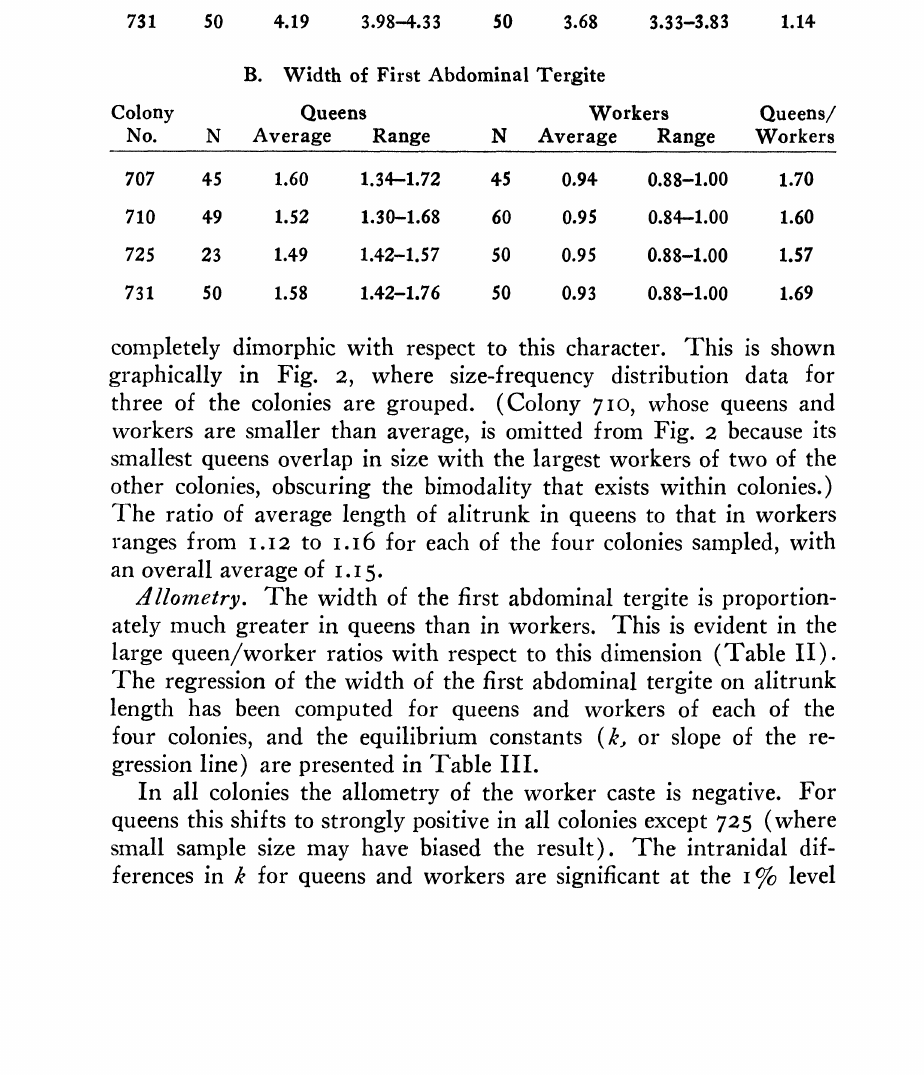
Table II. Queen/Worker Dimorphism in Stelololybia